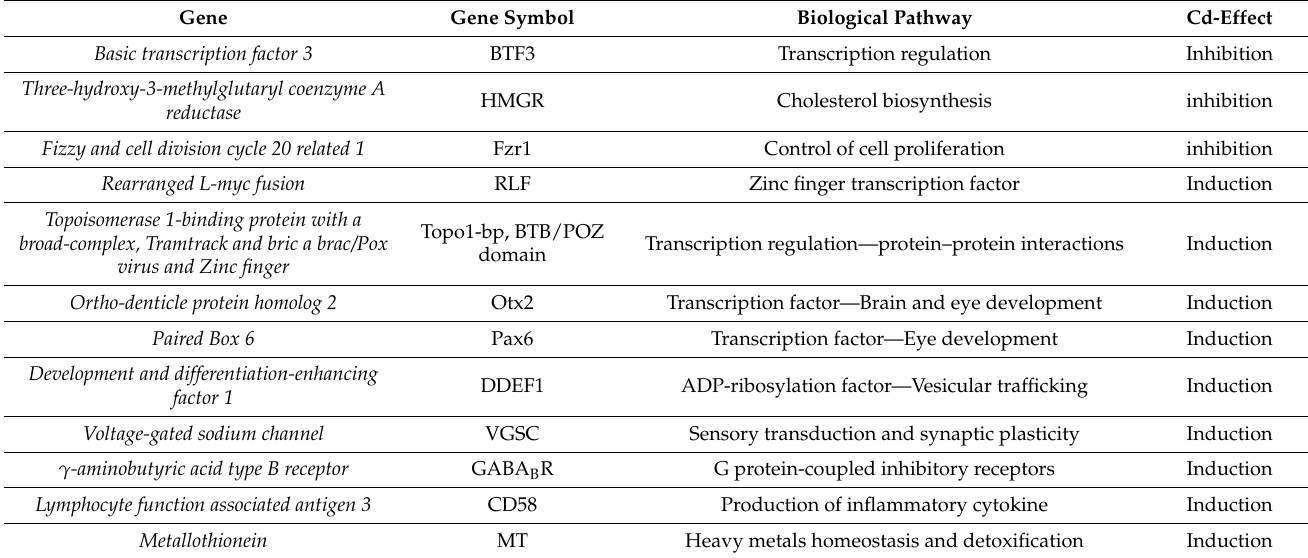
Table 1. Cadmium-responsive genes identified in 20-days-old P. siculus